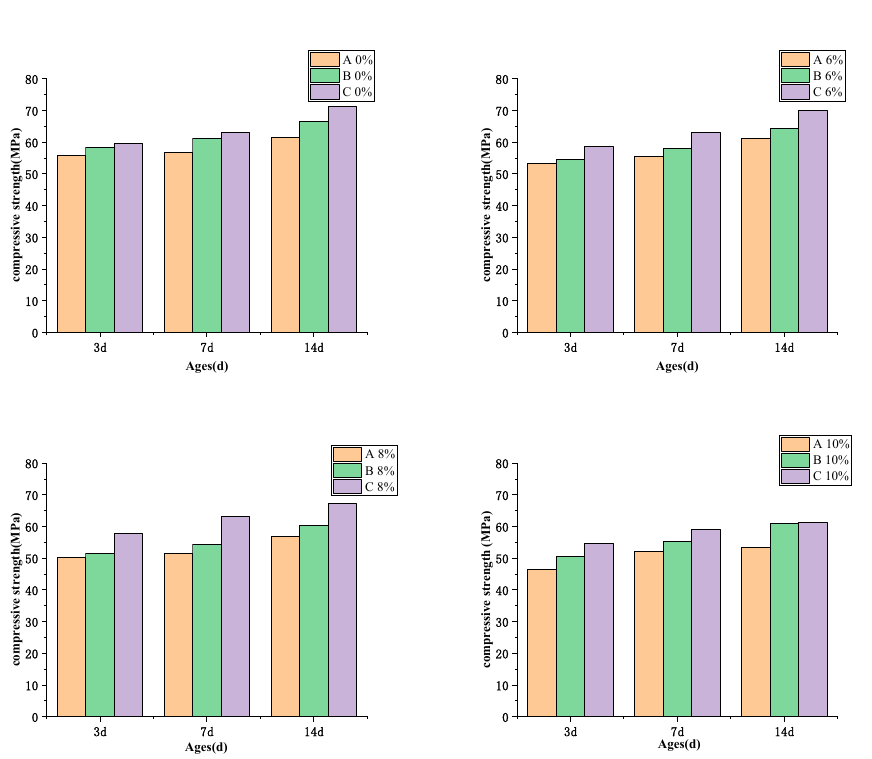
Figure 6. Effects of temperature conditions on the compressive strength of HPC mixed with Figure 6. E ff ects of temperature conditions on the compressive strength of HPC mixed with MEA.